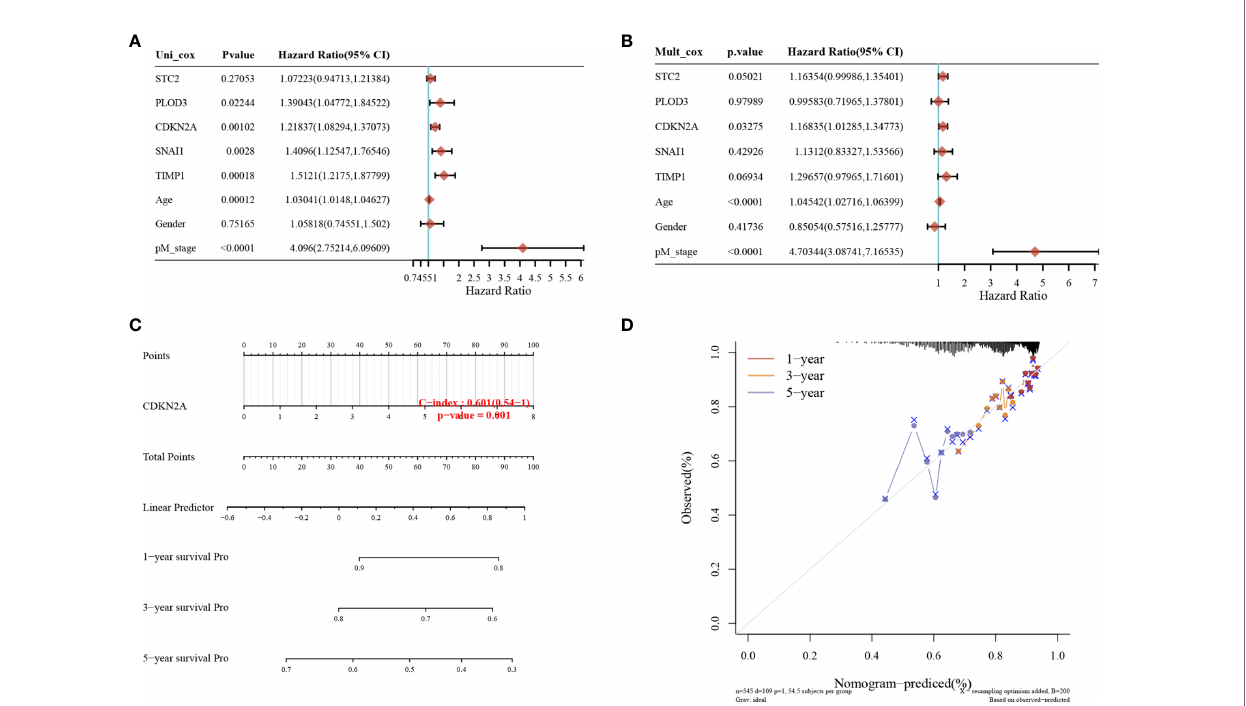
FIGURE 4 | Identi fi cation of independent prognostic factors for CRC and single-gene prognostic analysis. (A) Single-factor Cox regression analysis; (B) multi-factor Cox regression analysis; and (C, D) the nomogram model used to predict the OS of patients with CRC at one, three, and fi ve years. p < 0.05 was considered statistically signi fi cant.